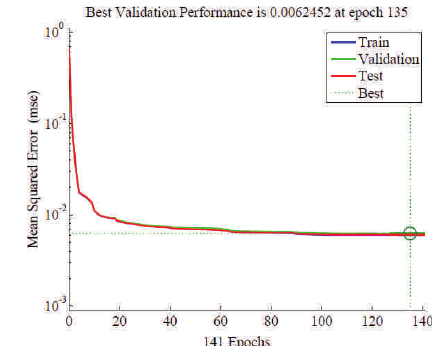
Fig. 7. Graph of errors for each subset during the ANN